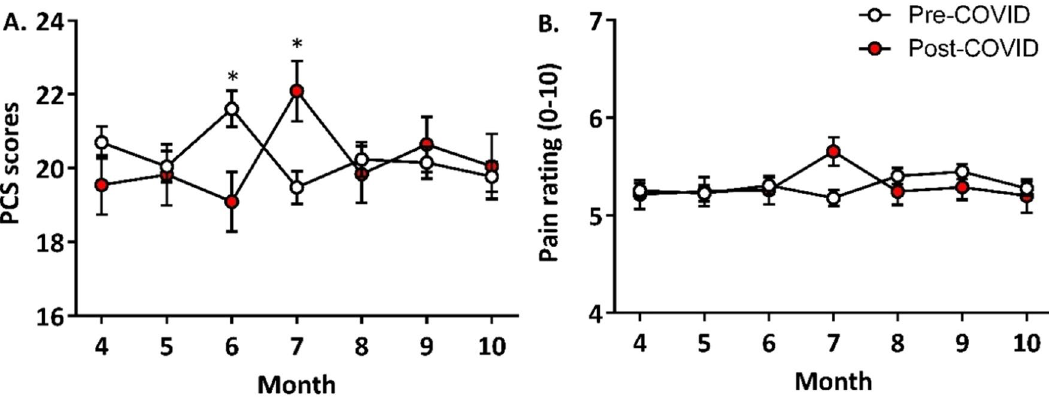
Figure 2. Comparing the changes in PCS scores ( A ) and pain ratings ( B ) by month between the pre- and post- COVID-19